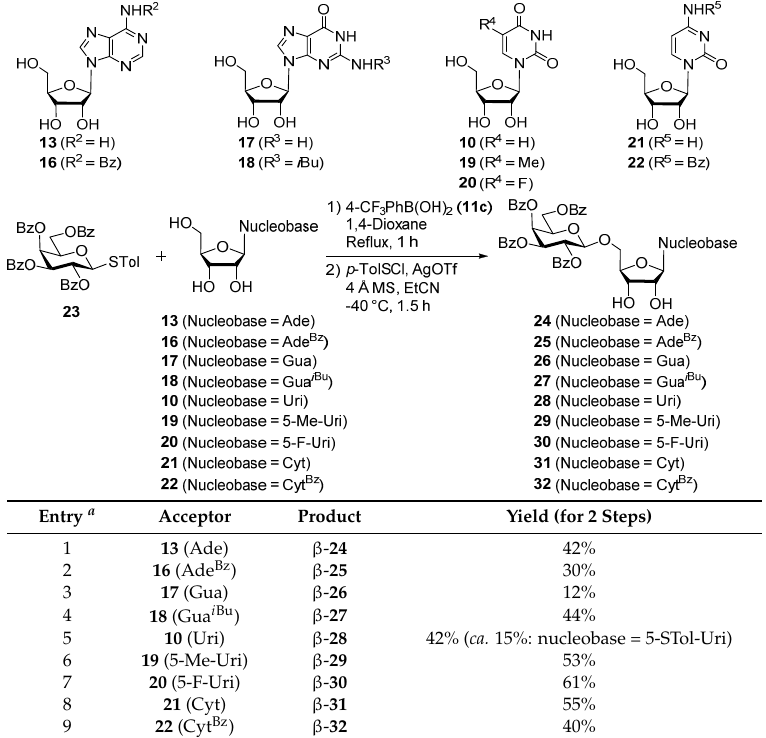
Molecules 2017 , 22 , 1650 5 of 21 phenomena similar to the O -glycosylation of 2’-deoxyadenosine reported by us in a previous study (Figure 1a) [40]. It should also be noted that the reaction of 13 with 23 (Entry 1) gave negligible amounts of N -galactosyl adenine as a byproduct unlike the use of the mannosyl donor 9 in an O -glycosylation reaction (Entries 2 and 3 in Table 2). In Entries 3 and 4, the reaction of the unprotected and N -protected guanosine, 17 and 18 [61], afforded the corresponding products β - 26 and β - 27 in 12% and 44%, respectively. The higher yield of β - 27 is possibly due to better solubility of the boronic ester intermediate prepared from the N -protected 18 in EtCN than that from the unprotected 17 . In Entry 5, the O -glycosylation of uridine 10 with 23 gave the desired product β - 28 in 42% yield, and the electrophilic substitution reaction at the 5-position of the uracil moiety of 10 and/or β - 28 with the p -toluenesulfenyl cation was observed ( ca. 15%) [62]. In Entries 6 and 7, the O -glycosylation of 5-metyluridine 19 and 5-fluorouridine 20 afforded the corresponding products β - 29 and β - 30 in 53% and 61%, respectively. In Entries 8 and 9, the reaction of the unprotected and N -protected cytidine,